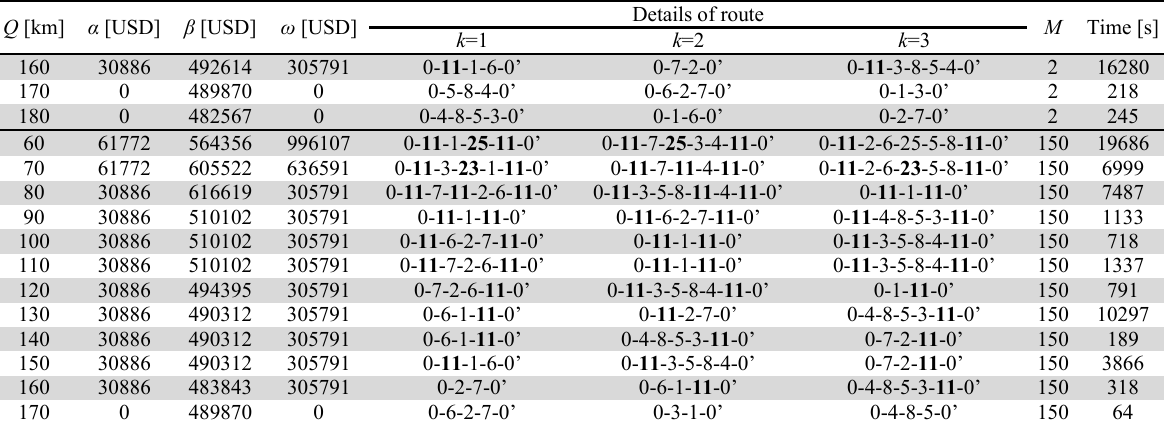
Results for instance